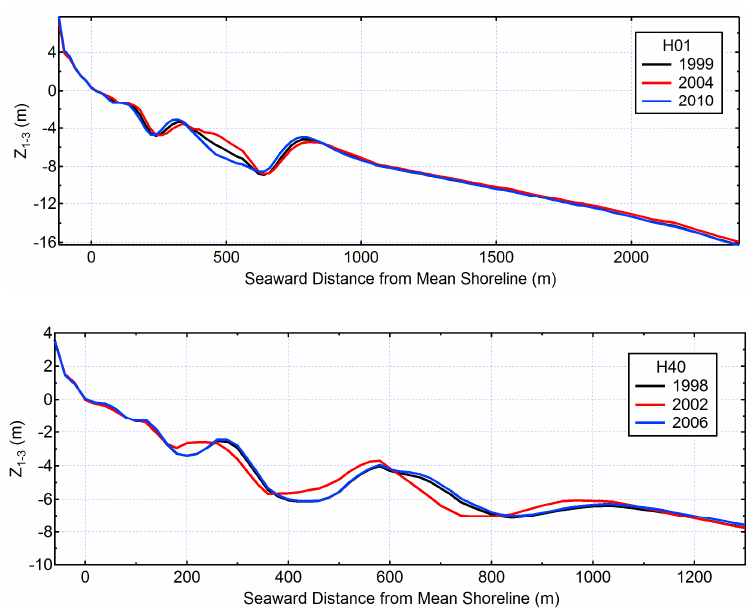
Figure 21. Examples of cross ‐ shore profiles when NOM ‐ related modes indicate shoreline advance.